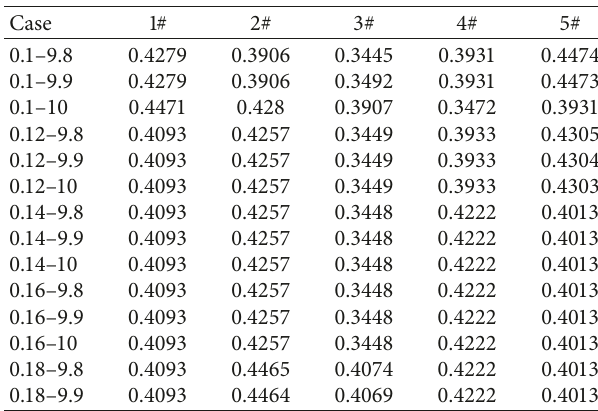
Table 2: Peak displacement